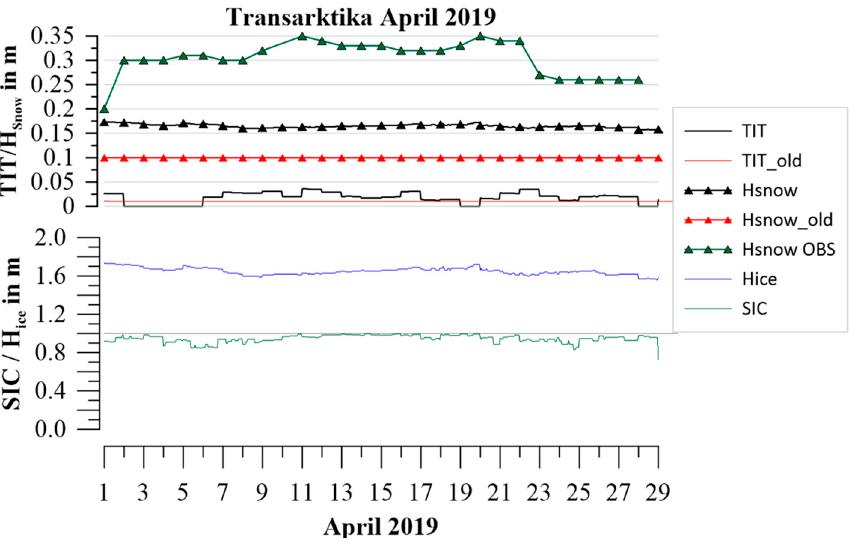
Figure 14. Sea ice conditions as used by CCLM for the grid point of R/V “ Akademik Tryoshnikov ” with daily resolution for 1–29 April 2019. Lower panel: sea ice concentration (SIC, green) and ice thickness (blue). Upper panel: sub ‐ grid scale thin ice thickness (lines without symbols, black/red: new/old parameterization.